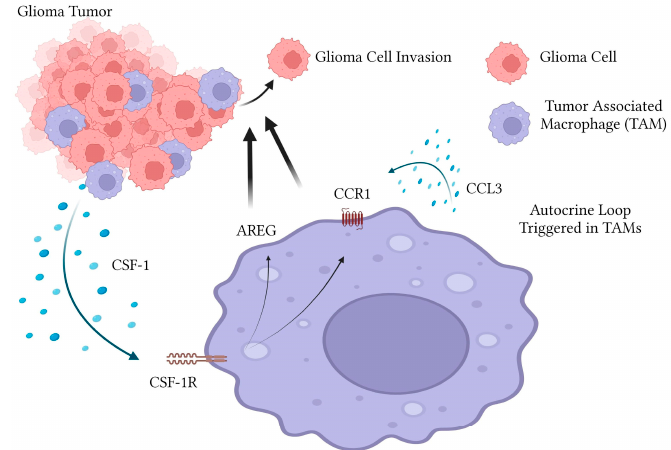
Figure 5. Model of microglia-stimulation of glioma invasion. Glioma cells secrete Colony Stimulating Factor-1 (CSF-1) which activates the CSF-1R and triggers the pro-invasion phenotype of tumor associated microglia/macrophages. This involves upregulation of C-C Chemokine Receptor Type 1 (CCR1) receptor and the EGFR ligand Amphiregulin (AREG). Glioma cells also stimulate upregulation of several CCR1 ligands, including Chemokine (C-C motif) Ligand 3 (CCL3). Blockade of this autocrine loop interferes with small molecule inhibitors of CSF-1R or CCR1 prevents tumor associated macrophage/microglia stimulated glioma invasion.